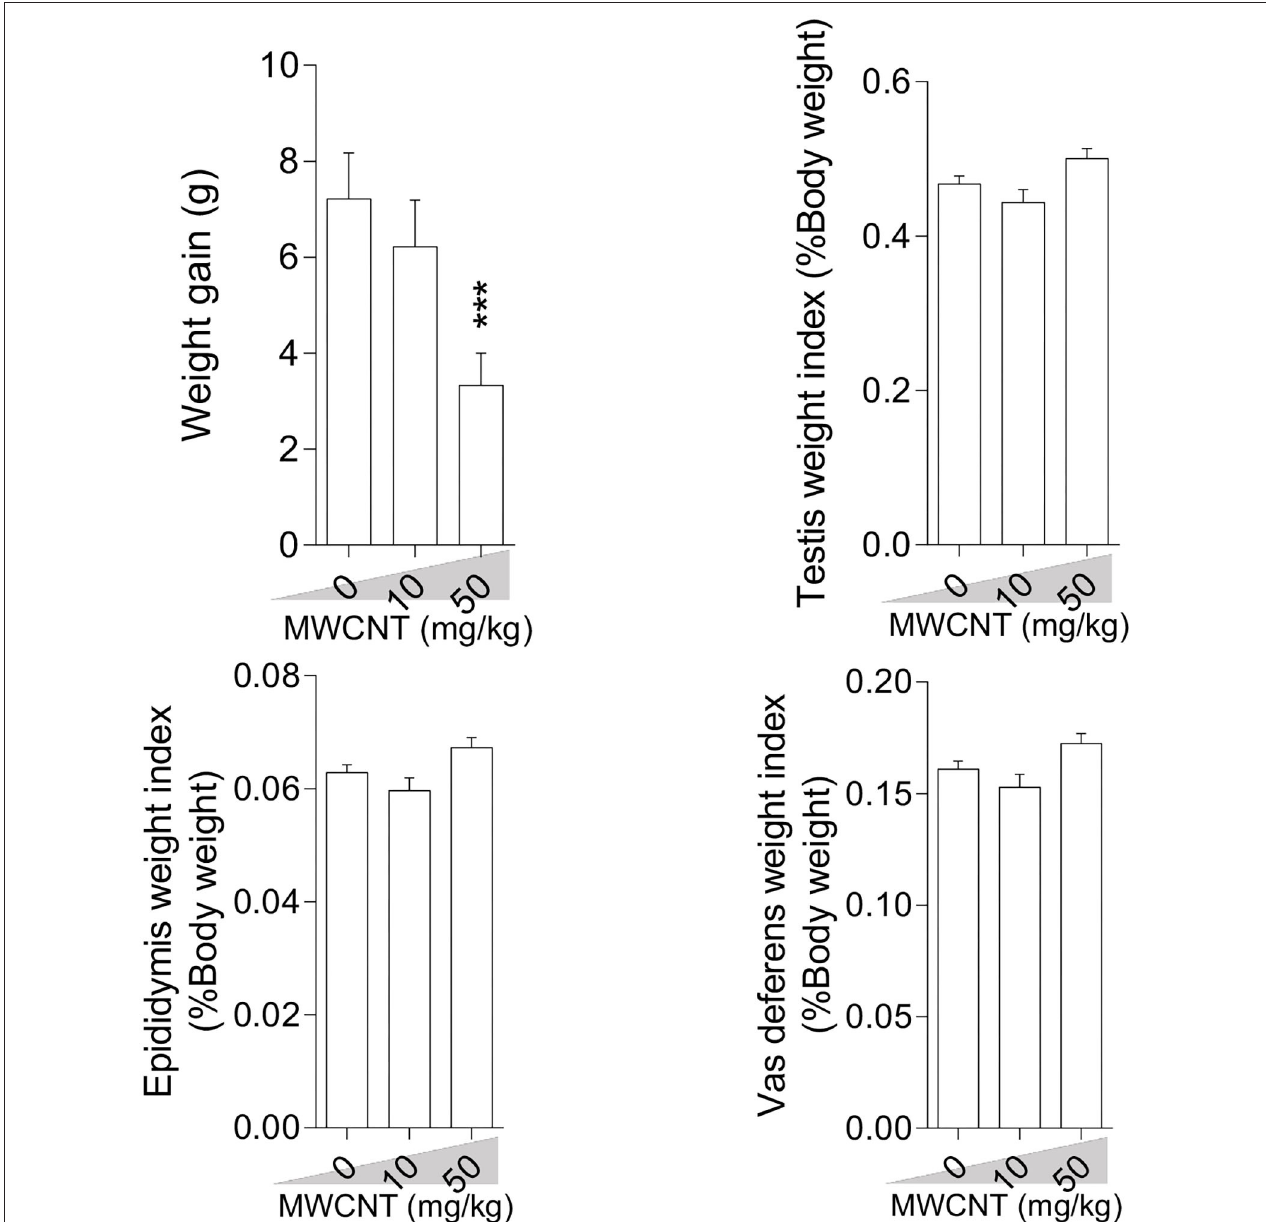
FIGURE 2 | Effect of multi-walled carbon nanotubes (MWCNT) on body weight gain and reproductive organ weight index in mice (mean ± SEM, n = 6). Asterisks indicate significant differences from the control group (*** P < 0.001).